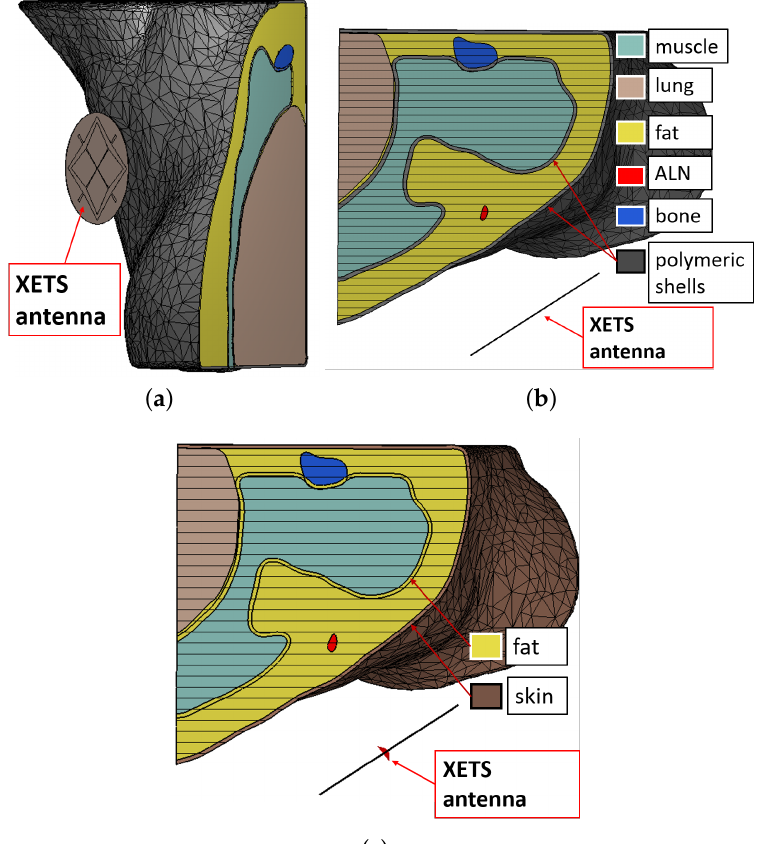
Figure 9. ( a,b ) Numerical model of the developed physical phantom ( Phantom ). ( a ) 3D-rendering view; ( b ) axial view at the level of the sternum. ( c ) Numerical model of the realistic axillary region ( Axilla ), in axial view. Each color represents a different component (legend). A crossed Exponentially Tapered Slot (XETS) antenna is placed close to the torso. Model size: 185 mm × 145 mm × 145